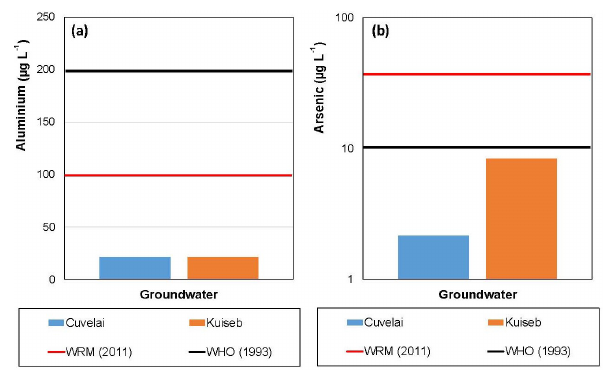
Figure 6. (a) Aluminium and (b) Arsenic levels in the Cuvelai- Etosha Basin and Kuiseb Basin. WHO → World Health Organisa- tion and WRMA → Water Resources Management